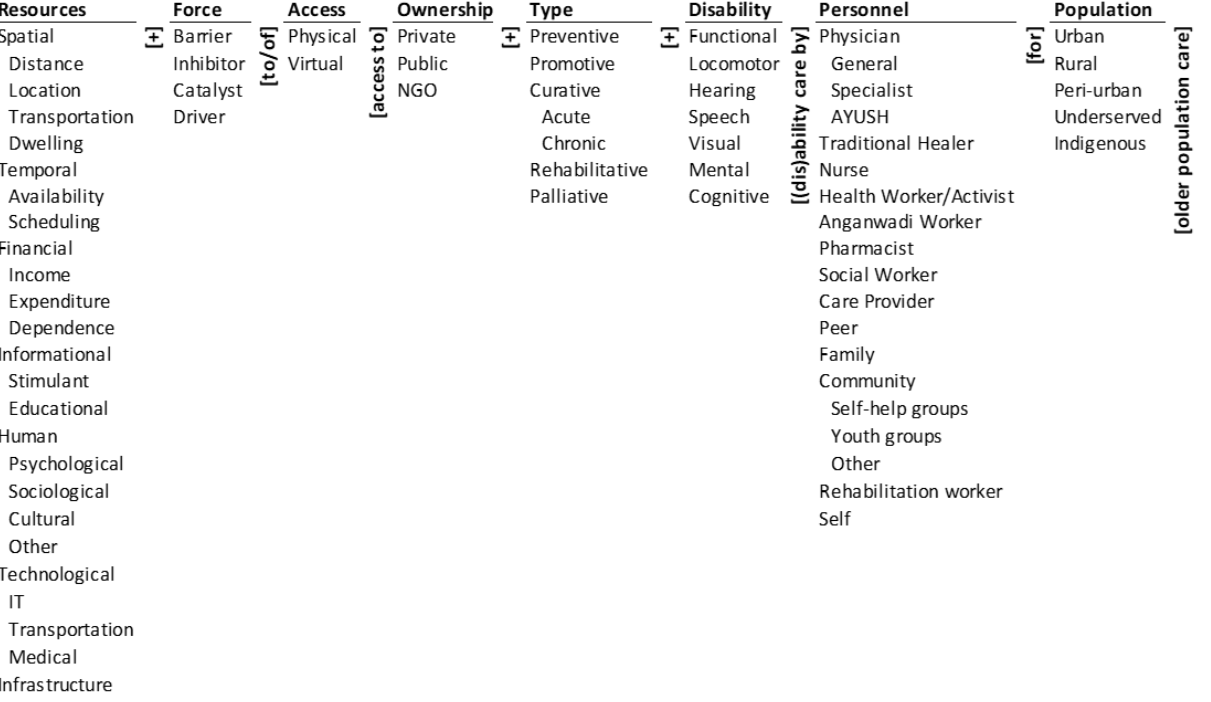
Figure 1. The ontology of barriers to and facilitators of access to geriatric disability care.